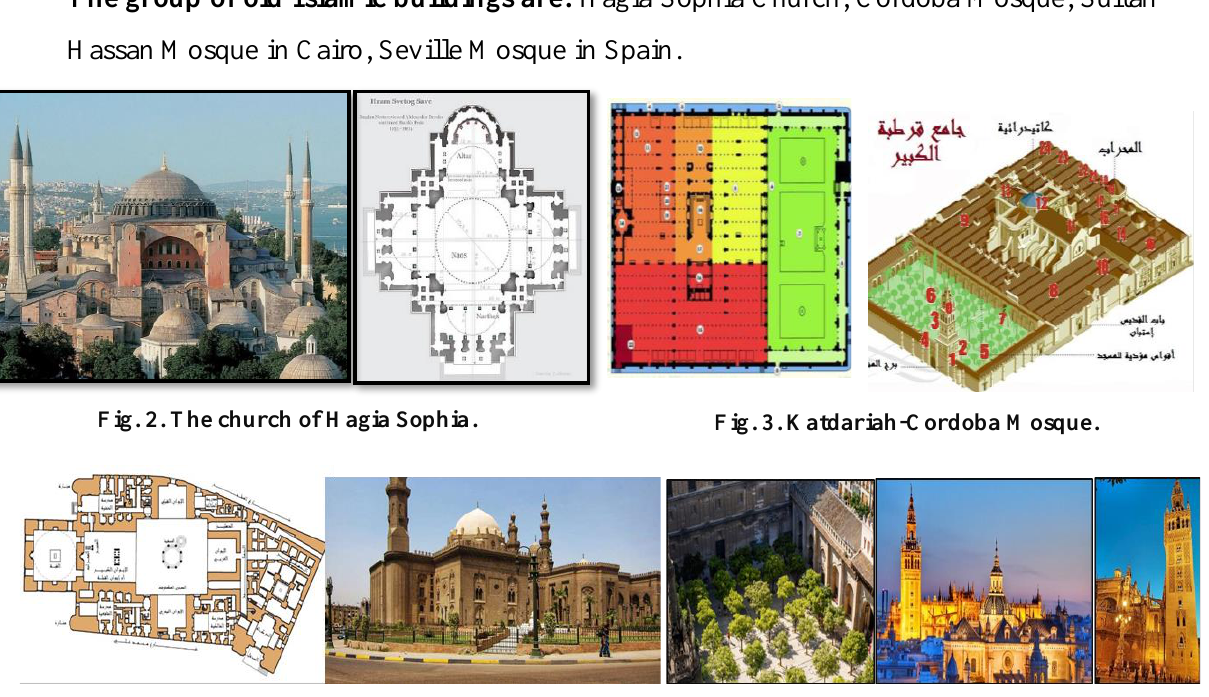
Fig. 4. The Sultan Hassan School and Mosque in Cairo . Source: https://byarchlens.com